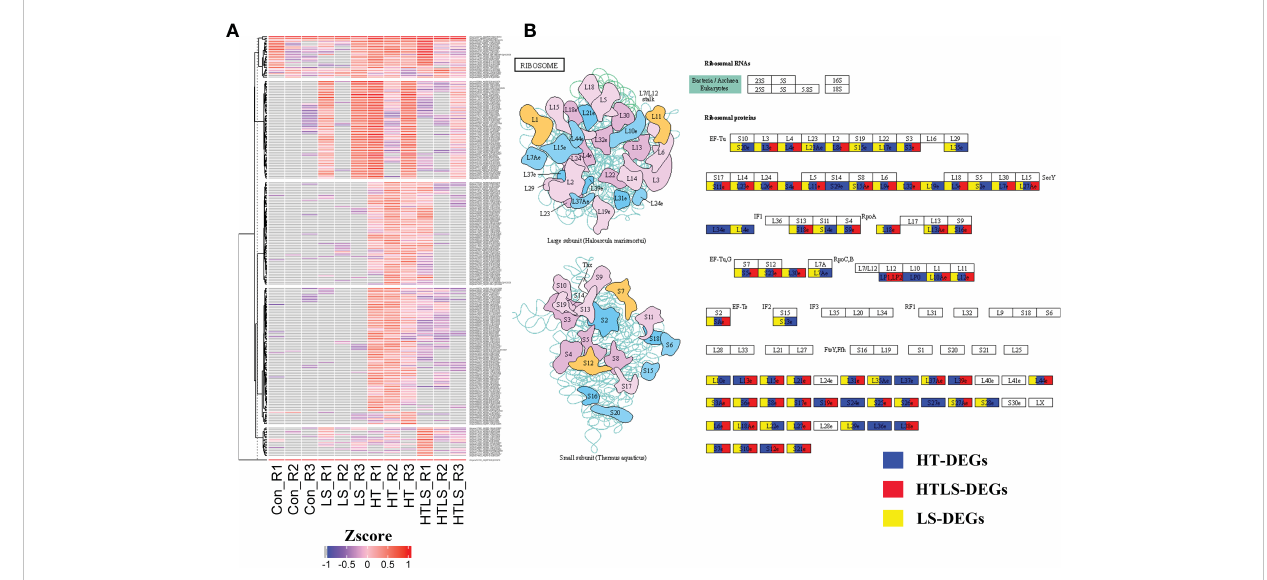
FIGURE 4 Differential expression of ribosomal protein genes in HT, LS and HTLS treatments. (A) Heatmap showing the expression pattern of DEGs mapped to “ Metabolic pathway ” in each replicate of each treatment. (B) The KEGG map of DEGs mapped to KEGG “ Metabolic pathway ” are shown. DEGs detected in HT, LS, and HTLS treatment are highlighted in blue, yellow, and red respectively.